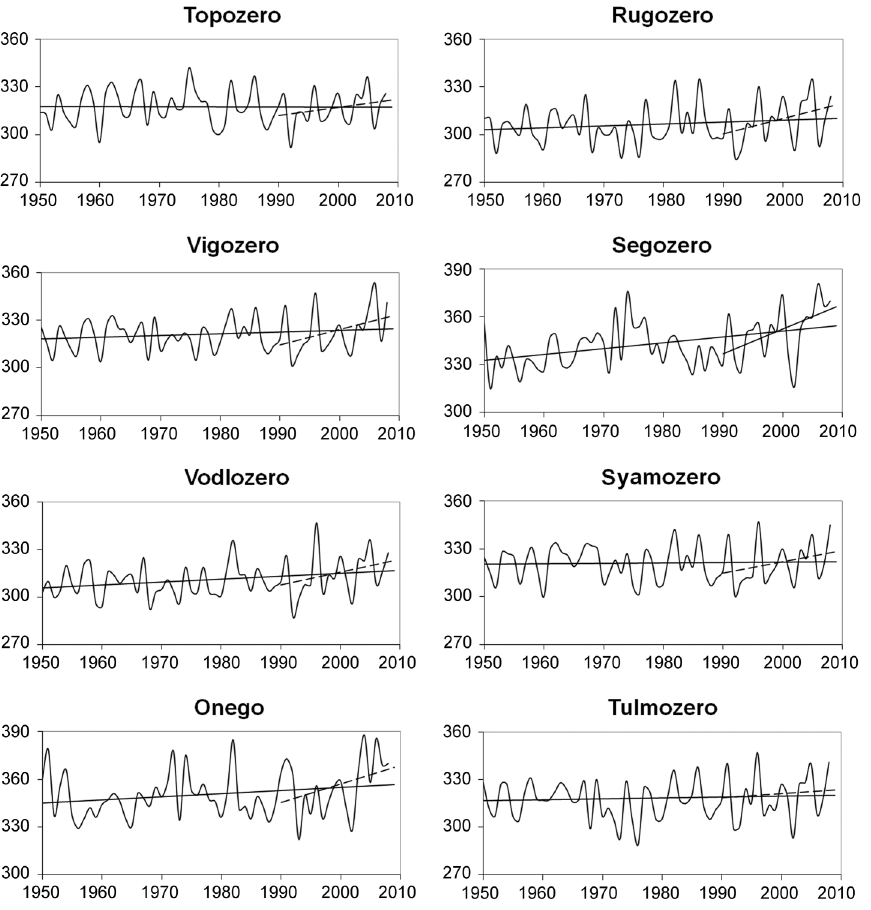
Fig. 3. Dates of freezing in